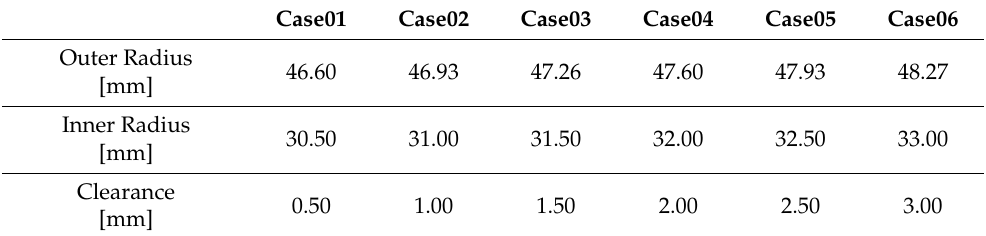
Table 4. Configuration clearance and radius dimension for construction model.